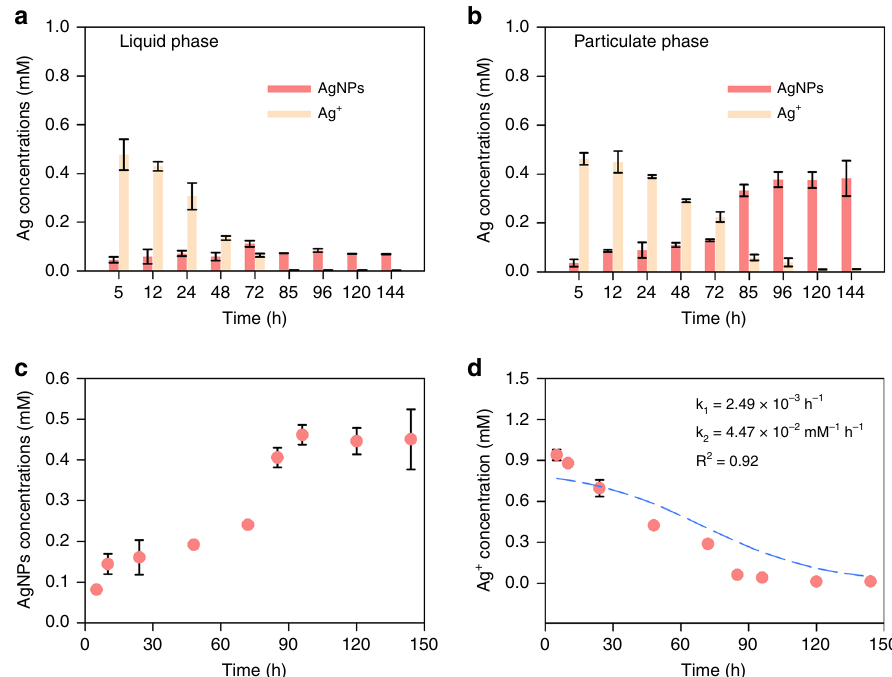
Fig. 3 Kinetics of silver nanoparticles formation. Silver ions (Ag + ) at 0.93 mM were incubated with particular organic matter (POM) at 143.2 mg C L − 1 under simulated sunlight at pH 8.6. The amount of AgNPs and Ag + in a liquid and b particulate phase. Total amount of c AgNPs and d Ag + in the heterogeneous system, and the experimental data were fi tted using the Finke – Watzky model. Error bars represent the standard deviation of the mean of the triplicates